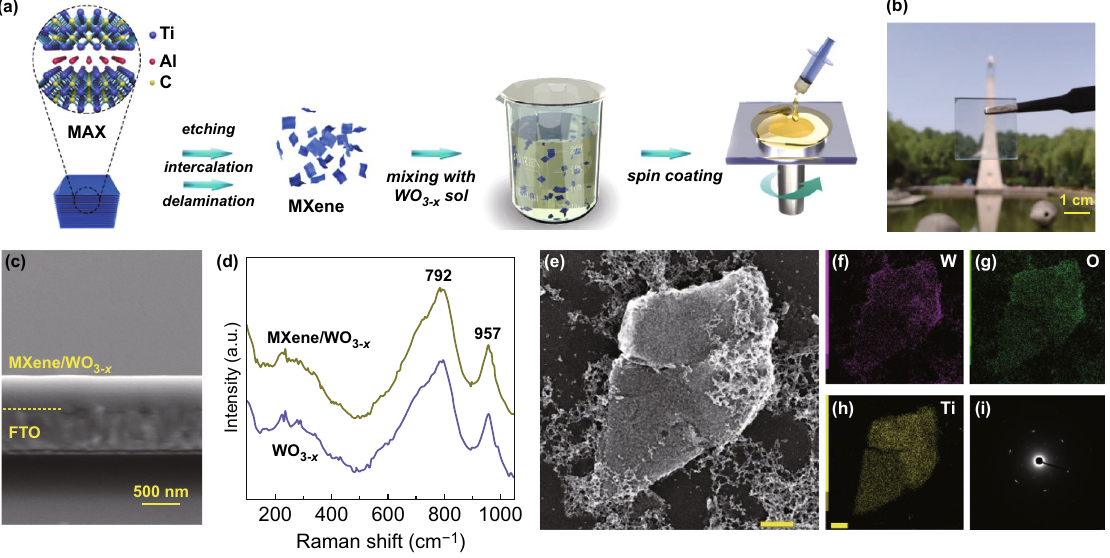
Fig. 1 a Schematic diagram depicting the fabrication process of MXene/WO 3− x films. b A photo of the prepared MXene/WO 3− x film on FTO glass (2.5 × 2.5 cm 2 ). The scale bar is 1 cm. c Cross-sectional SEM of the MXene/WO 3− x film. d Raman spectra of the pure WO 3− x and